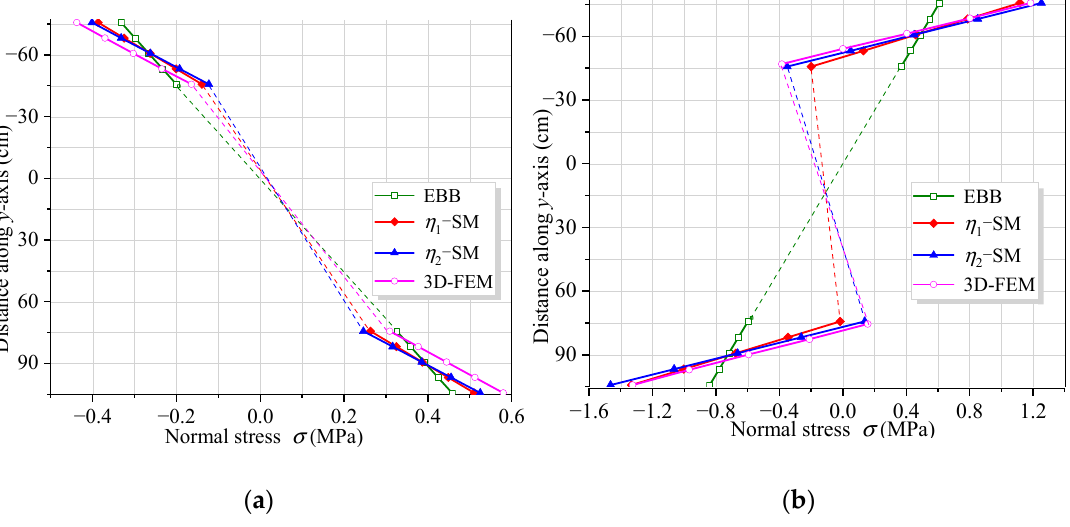
Figure 12. Vertical distribution of normal stress along the cross-section under load case 2: ( a ) cross-section 9.0 m away from the middle support; ( b ) cross-section 0.3 m away from the middle support.